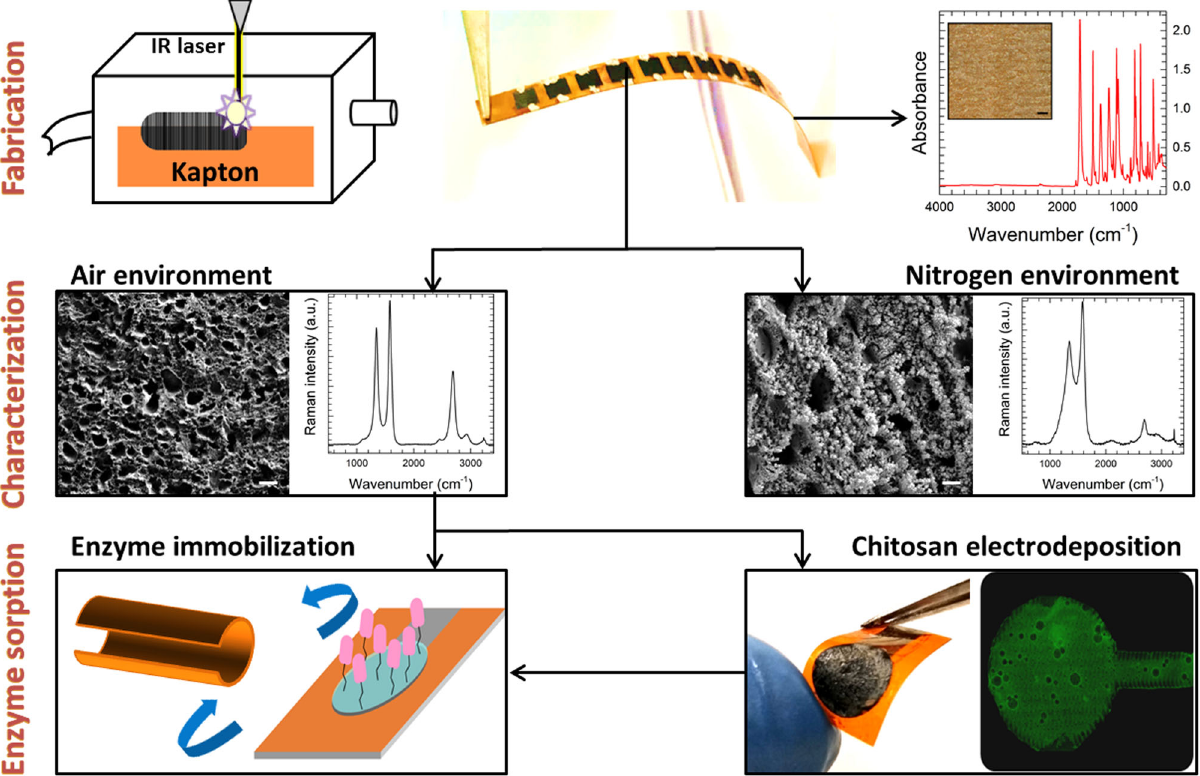
Fig. 1 Schematic diagram of the experimental approach. Process steps: fabrication of carbon structures on Kapton, characterization of laser carbon, and enzyme adsorption on laser carbon with and without chitosan layer. Scale bars on the SEM micrographs are 10 μ m. Parts of this image are adapted from Mamleyev et al.